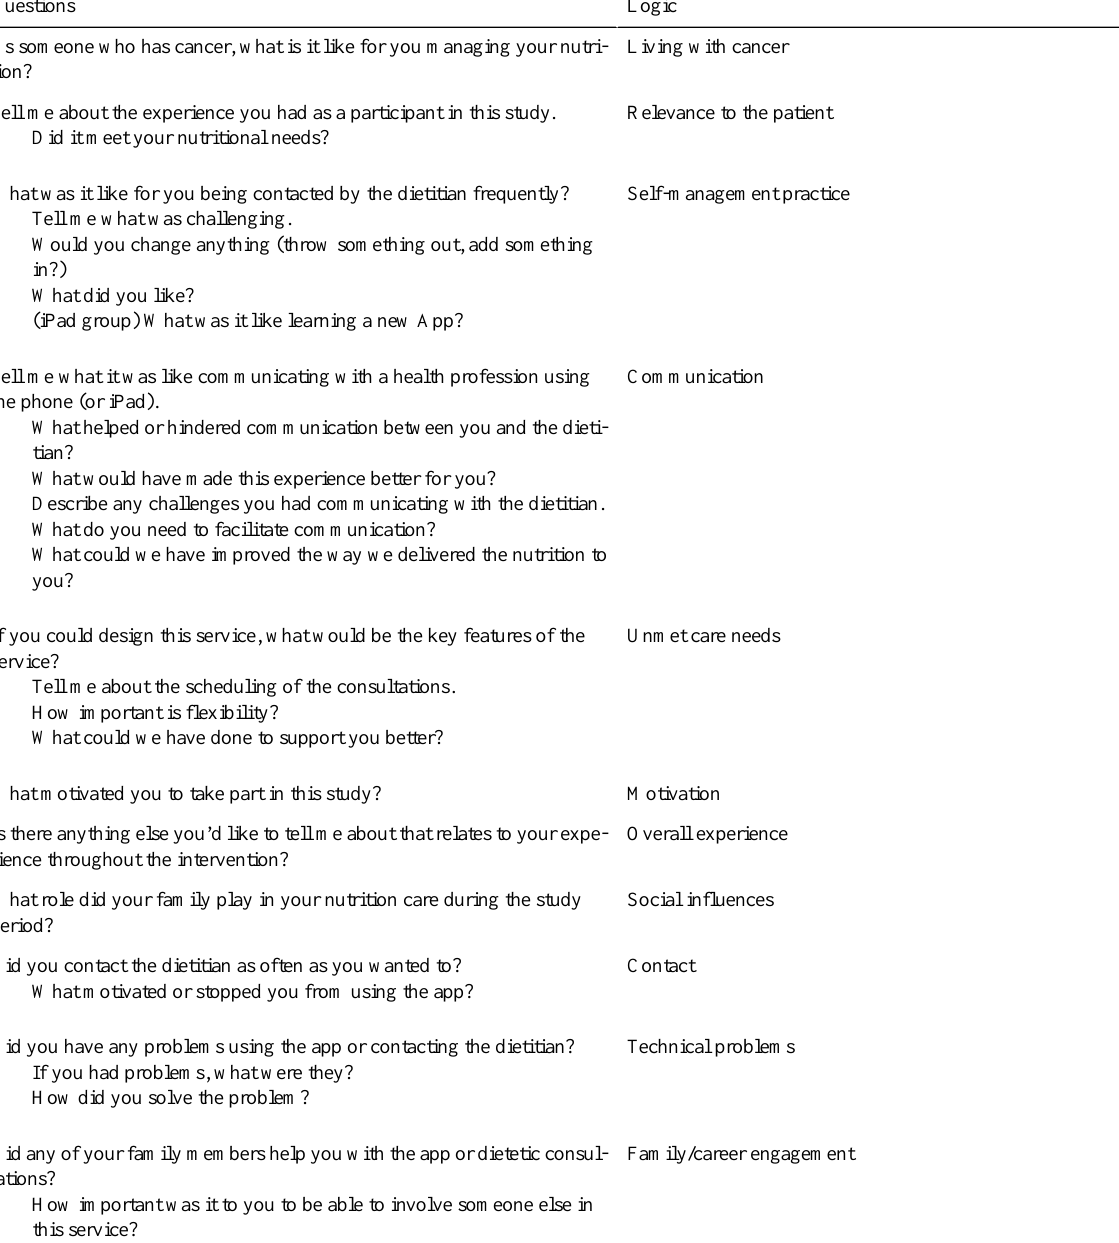
Table 1. Semistructured postintervention interview questions.